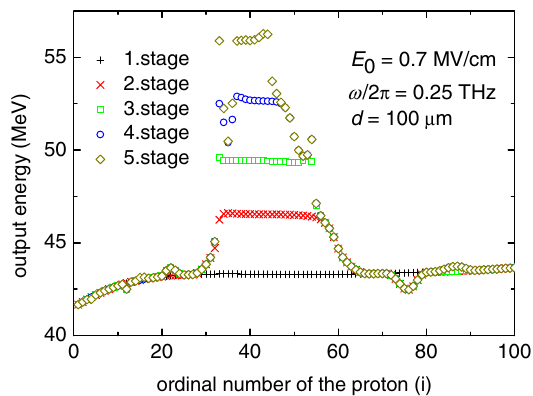
FIG. 8 . Output proton energy distributions for the subsequent stages of a five-stage accelerator sequence in the case of 0.25 THz